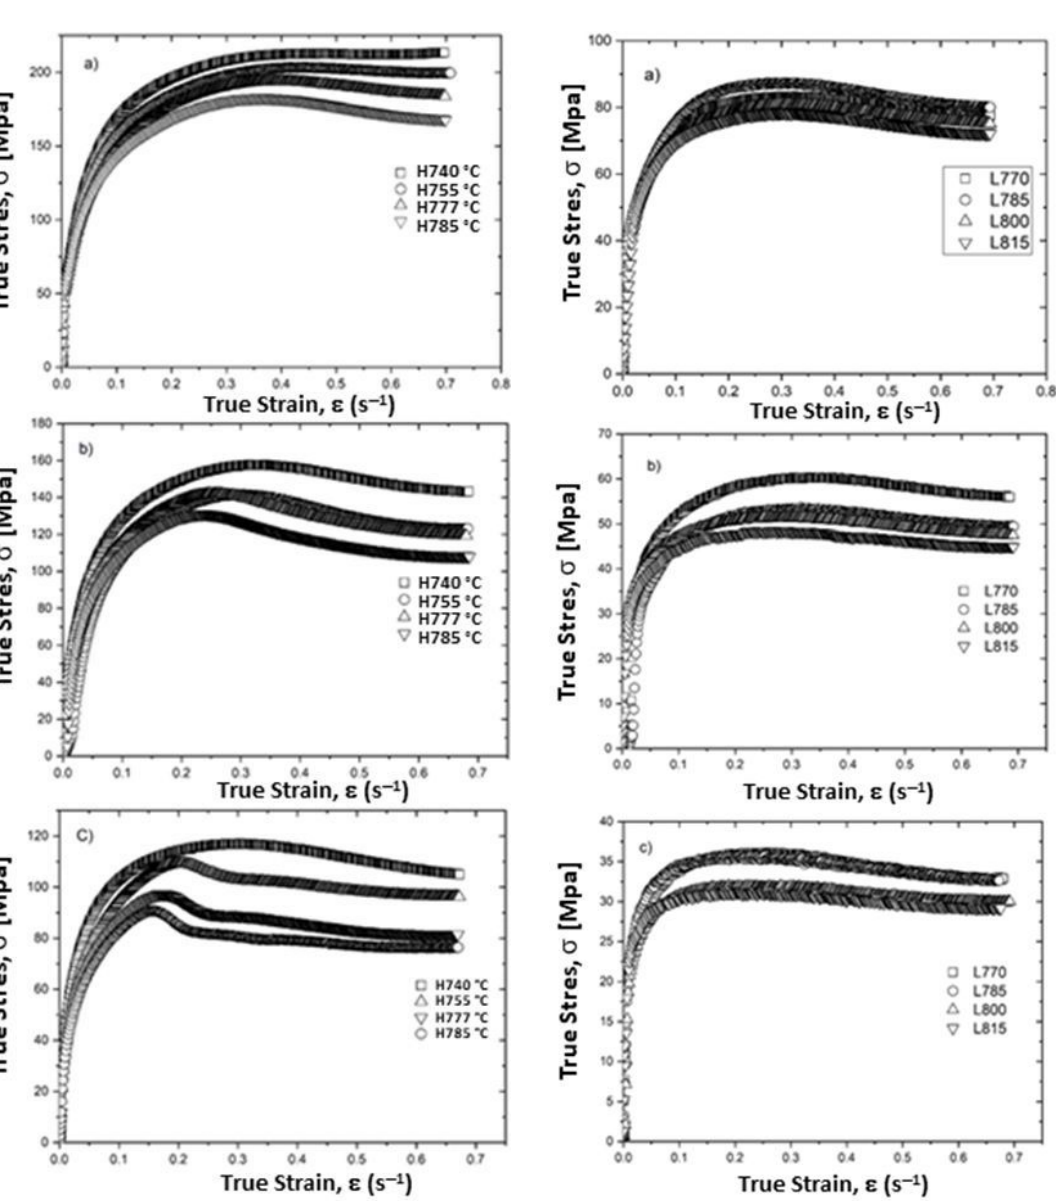
Figure 5. Experimental compression strain curves at different temperatures and strain rate, a) 0.1 s -1 , b) 0.01 s -1 , and c) 0.001 s -1 low carbon steel.